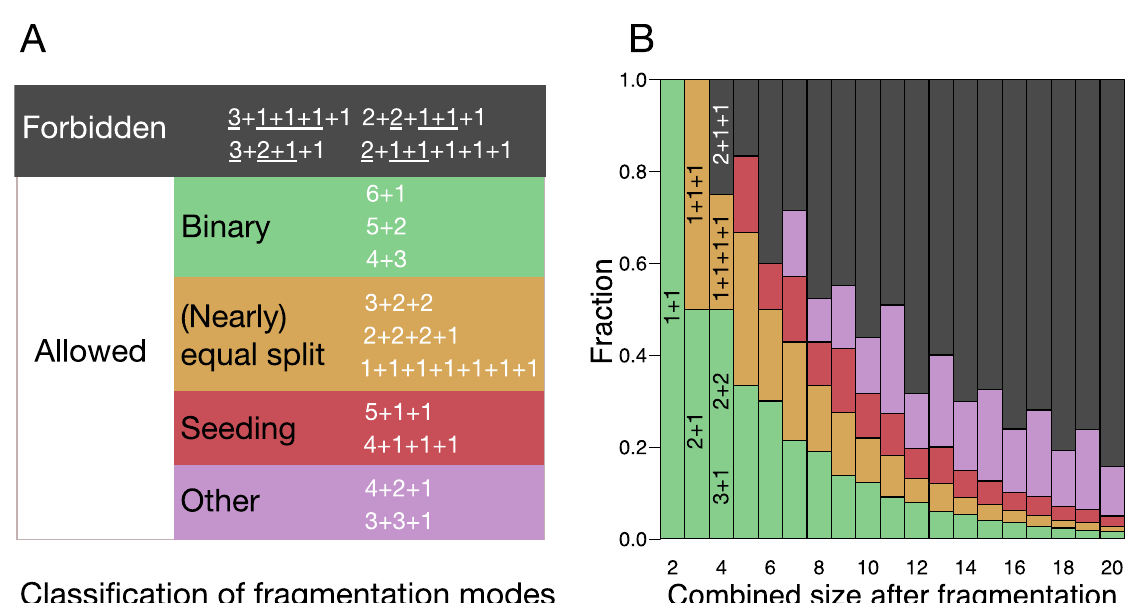
Fig 3. The majority of life cycles cannot win growth competition and are thus called forbidden. ( A ) All possible fragmentation modes with combined fragments size equal to 7. Allowed modes are further broken into binary, (nearly) equal split, seeding, and other classes, according to the definitions in the main text. For each of the forbidden modes, a couple of different subsets of parts with the same sum are underlined. ( B ) Proportions of different classes of fragmentation modes for different combined size at fragmentation. For sizes 2 and 3, all partitions are allowed. Starting from size 4, some are forbidden (for 4, it is 2+1+1). The proportion of forbidden modes grows rapidly with the size. For even sizes, more forbidden modes exist. Among the allowed modes, the proportions of binary, (nearly) equal split and seeding classes rapidly